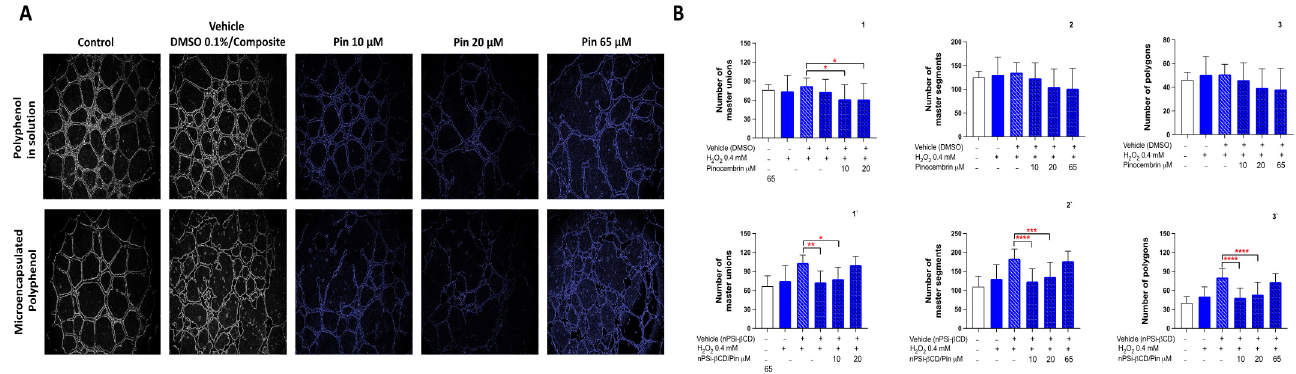
Figure 7. Effect of treatment with pinocembrin in solution and loaded in the nPSi- β CD composite microparticle on the ability of HUVECs to form tubular structures in Matrigel. ( A ) Images were taken at 8 h and are representative for each treatment group. ( B ) Effect quantification of treatment with pinocembrin in solution and loaded in the nPSi- β CD composite microparticle on the ability of HUVECs to form tubular structures in Matrigel. ( 1 , 1‘ ) number of master unions, ( 2 , 2‘ ) number of master segments, and ( 3 , 3‘ ) number of polygons formed. The numbers 1, 2, and 3 correspond to the polyphenol in solution, while 1‘, 2‘, and 3‘ correspond to the microencapsulated polyphenol. Statisti- cally significant differences are indicated compared to the control treatment (vehicle). (* = p < 0.05, ** = p < 0.01, *** = p < 0.001, **** = p < 0.0001, n =